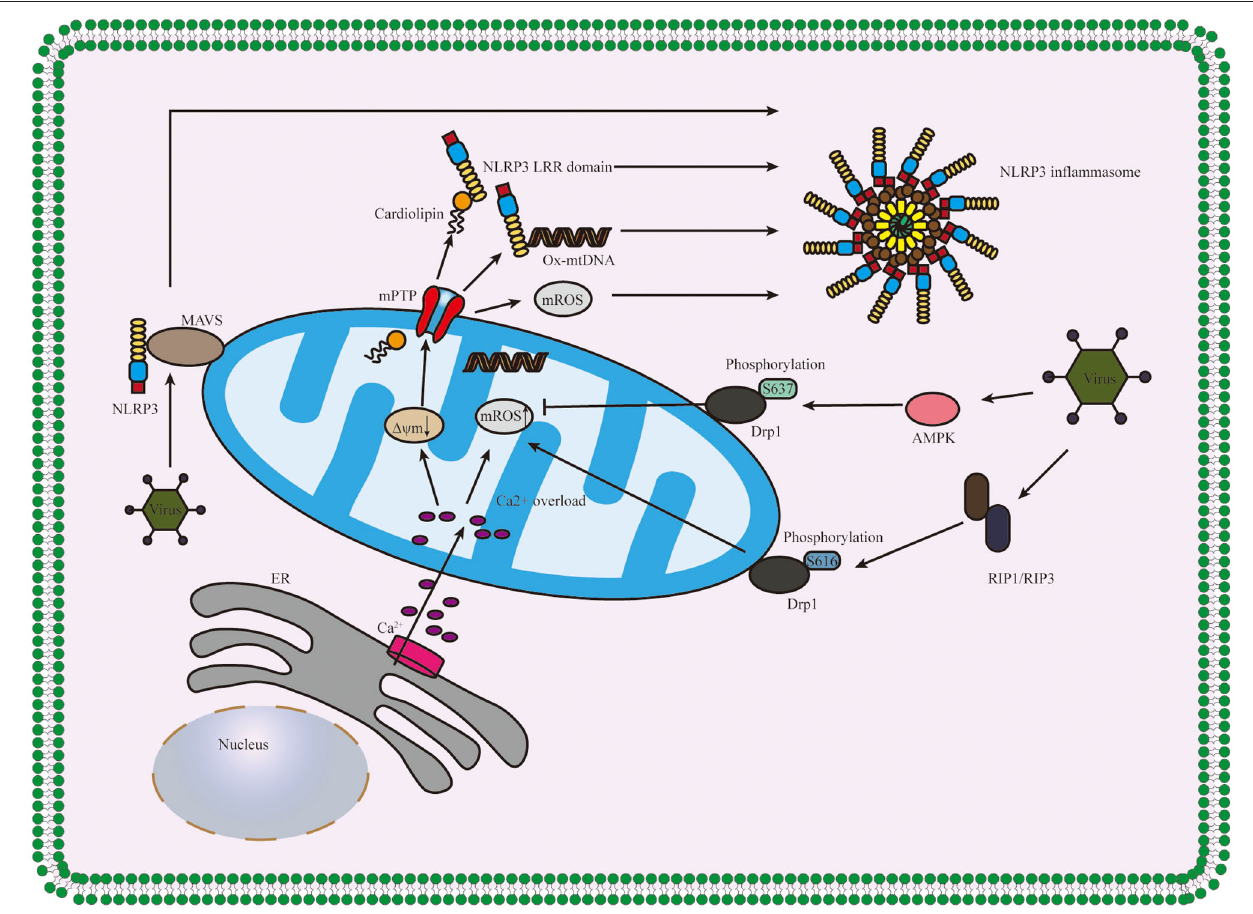
FIGURE 3 | Diagram of the role of the mitochondrion in NLRP3 inflammasome activation. Ca 2 + which released from ER influxes into mitochondria, and the overload of Ca 2 + contributes to the high mitochondrial membrane potential ( 1ψ m) depolarizes and the opening of mPTP, thus releasing mitochondria-derived molecules such as mROS, mtDNA and cardiolipin which produced during mitochondrial destabilization. The cardiolipin and ox-mtDNA release into cytosol and then bind to NLRP3, which might serve as NLRP3 ligands to activate the NLRP3 inflammasome. The infection of the virus accelerates the recruitment of NLRP3 to mitochondria and binds between NLRP3 and MAVS and regulates the mitochondrial destabilization and NLRP3 inflammasome activation in Drp1 phosphorylation-dependent ways. NLRP3, pyrin domain-containing protein 3; ER, endoplasmic reticulum; mPTP, mitochondrial permeability transition pore; MAVS, mitochondrial antiviral signaling protein; AMPK, AMP-activated protein kinase; RIP1/RIP3, receptor-interacting serine/threonine kinase 1 and RIP3; 1ψ m, mitochondrial membrane